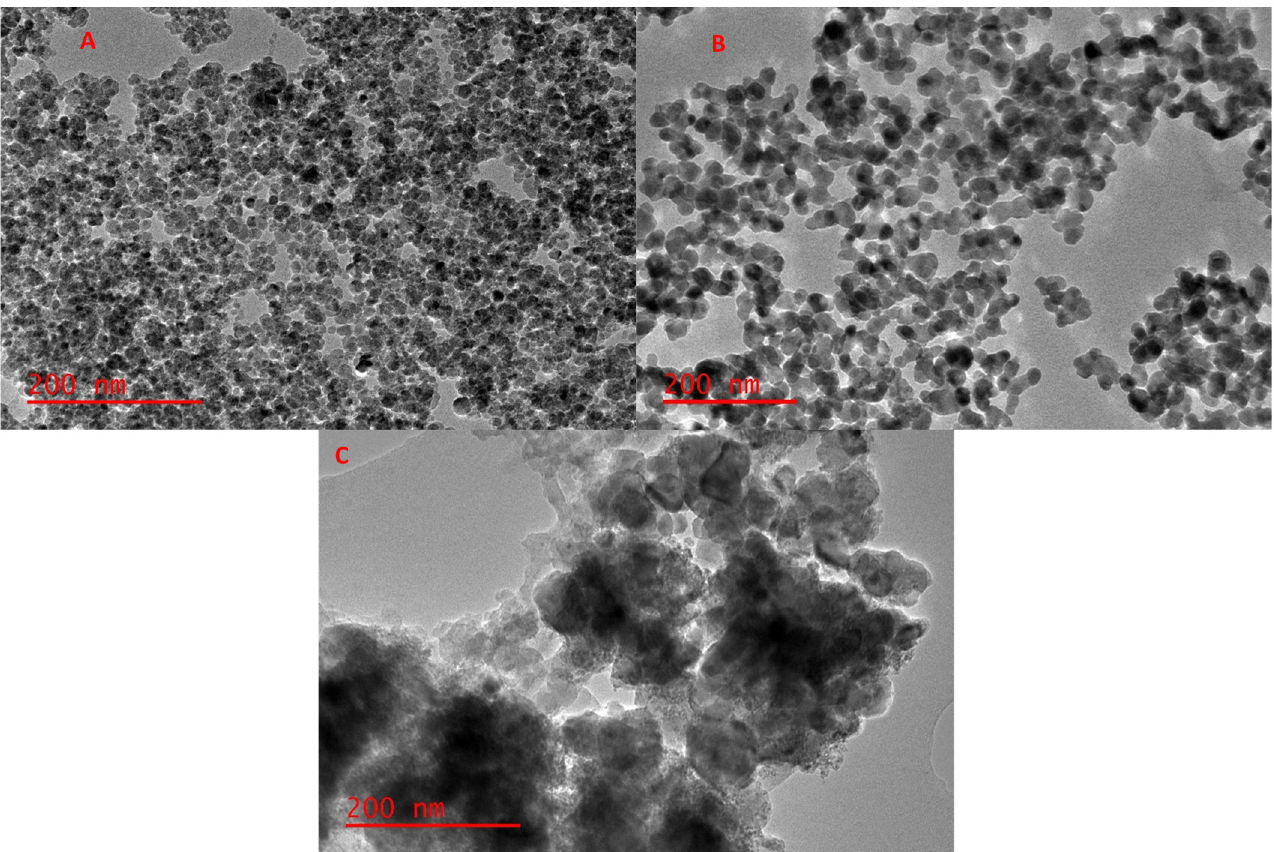
Figure 4. TEM images for the ( A ) Fe 3 O 4 nanoparticles, ( B ) Fe 3 O 4 -ZrO 2 and ( C ) Fe 3 O 4 -ZrO 2 @APS nanocomposites.